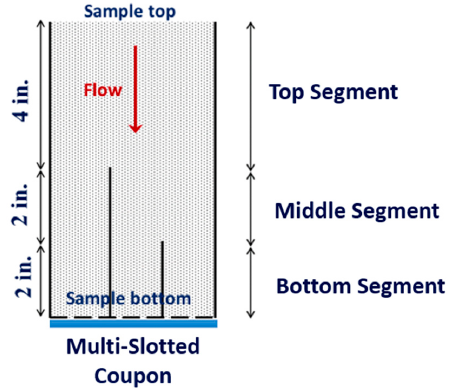
Figure 3. Schematic view of three segments of sand-pack.